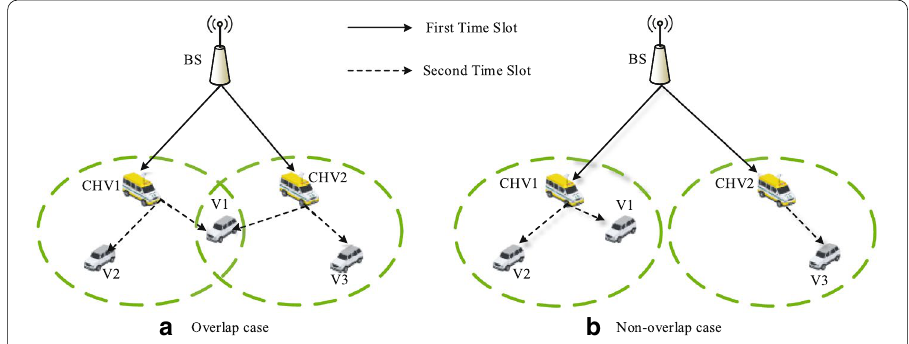
Fig. 1 The proposed NOMA-IoV network: a overlap case, b non-overlap